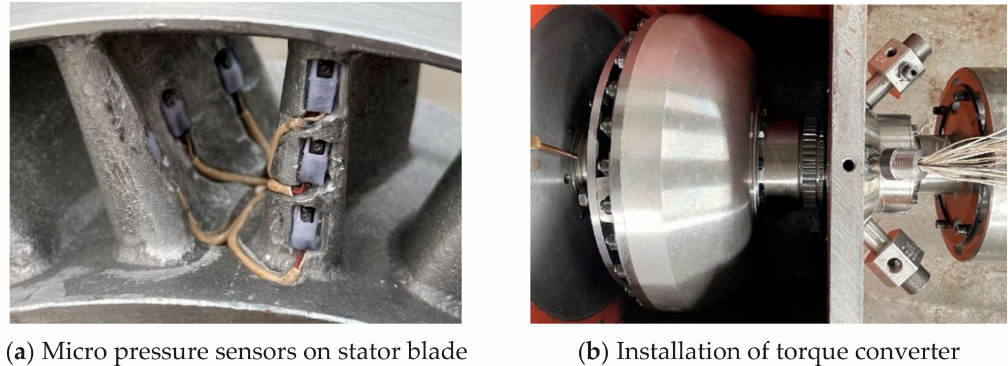
Figure 6. Micro pressure test of internal flow field in torque converter.